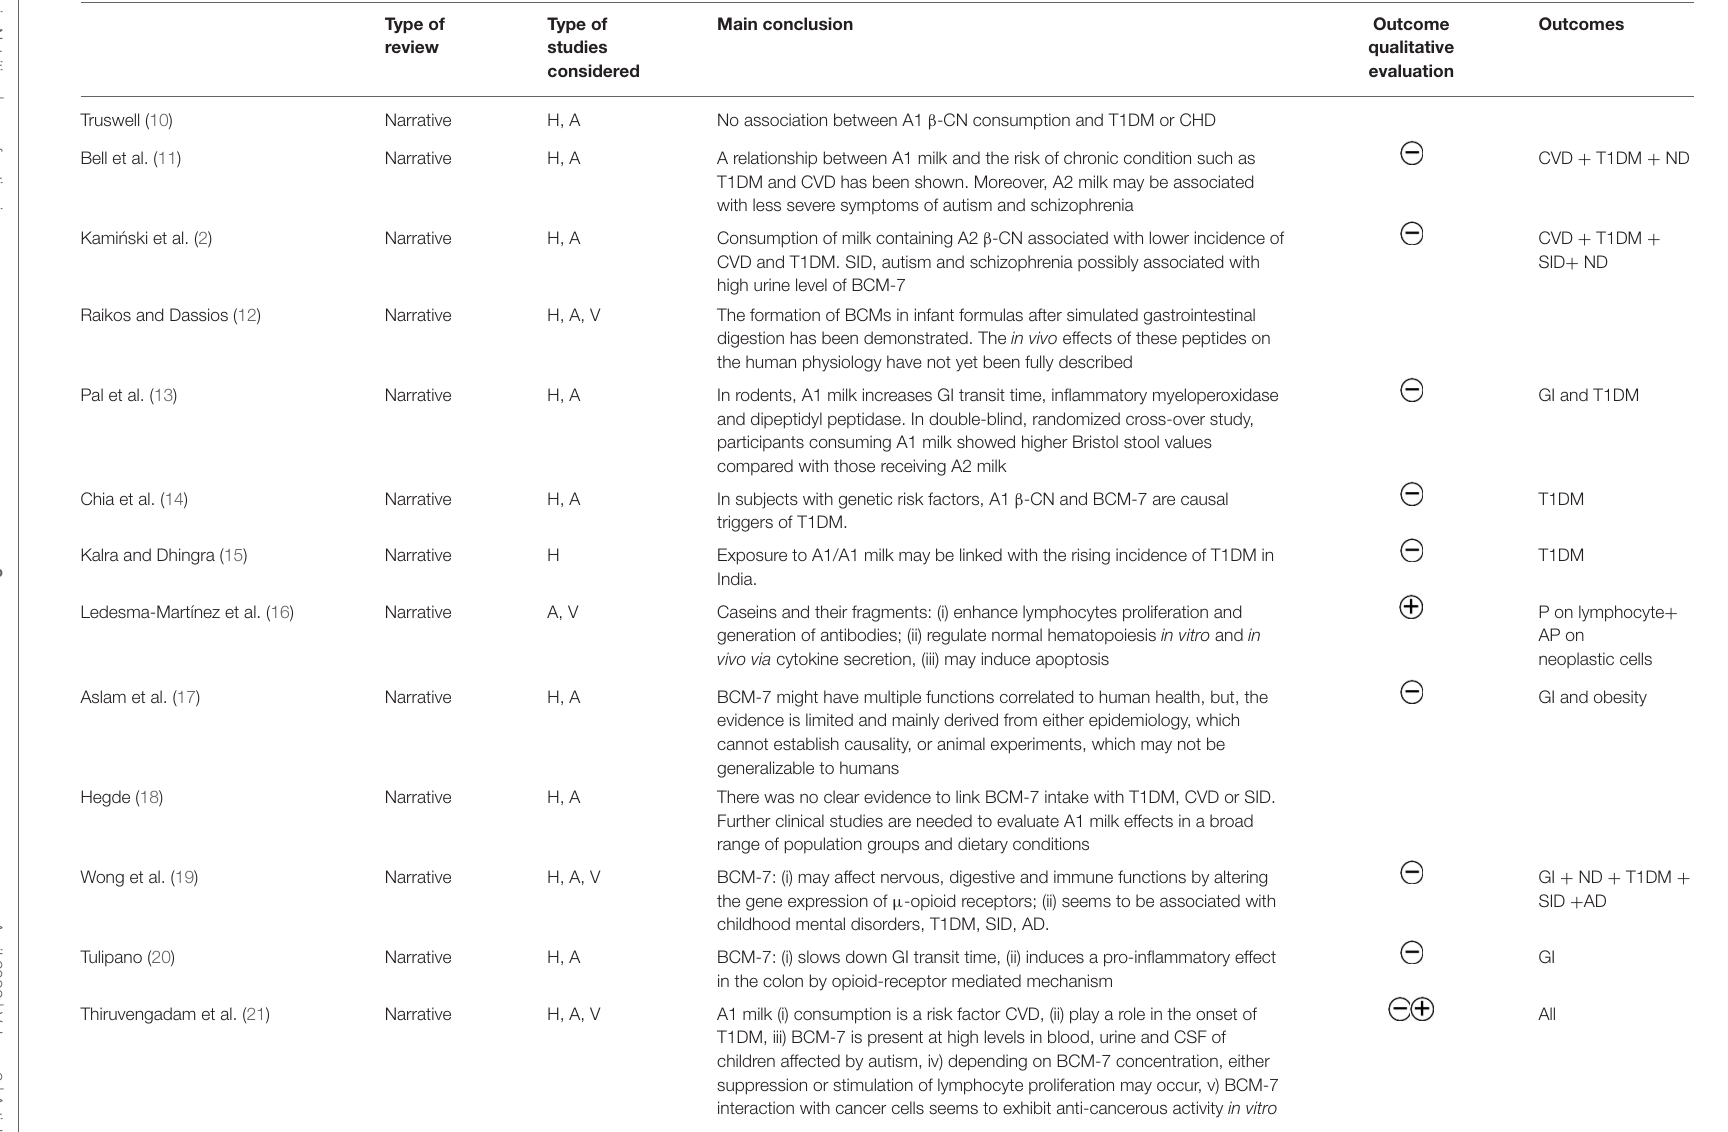
TABLE 1 | List of the selected review papers reporting the association between of A1 or A2 β -casein consumption and health